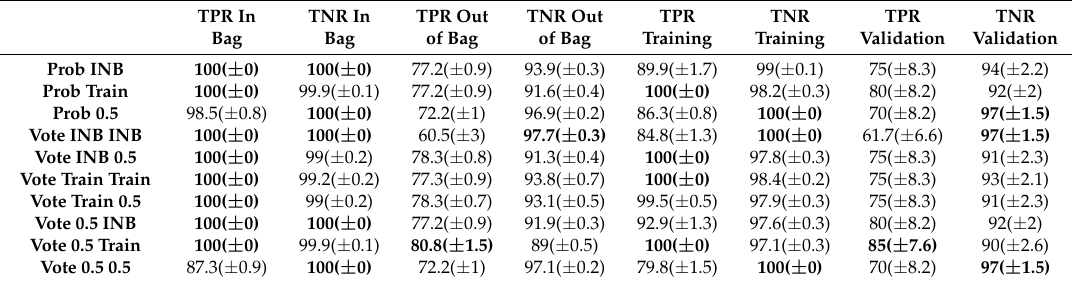
Table A1. True Positive Rate (TPR) and True Negative Rate (TNR) for Asystole.